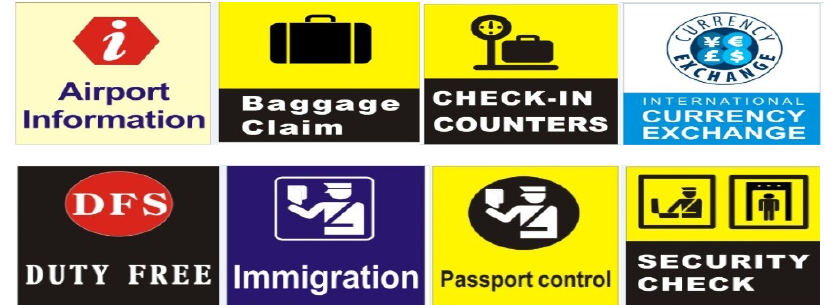
Figure 5. The eight trigger images for airport situational contexts.